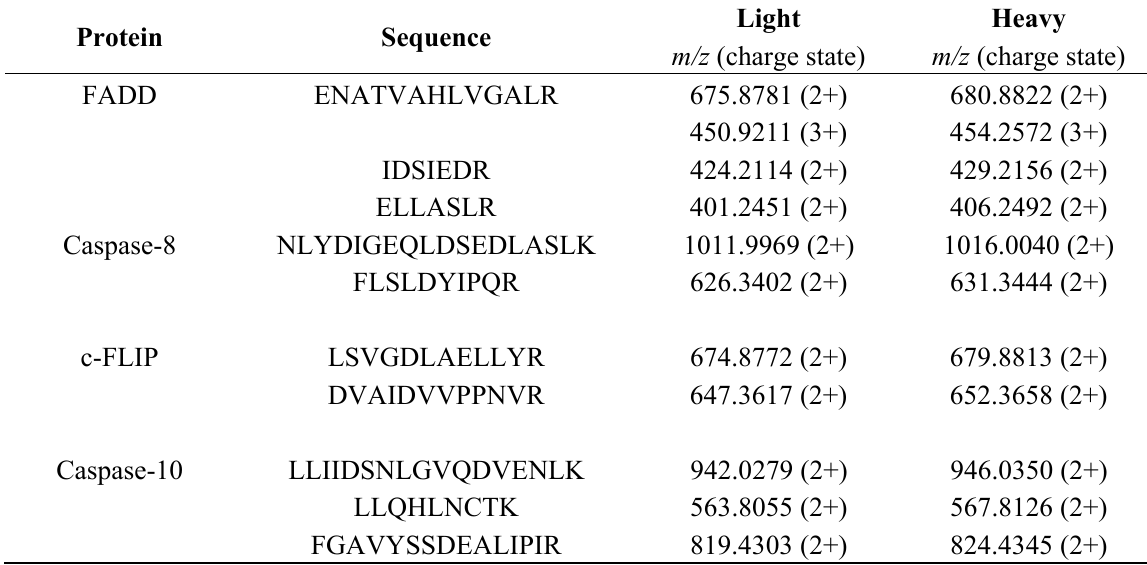
, 15 N ] arginine at their respective 6 4